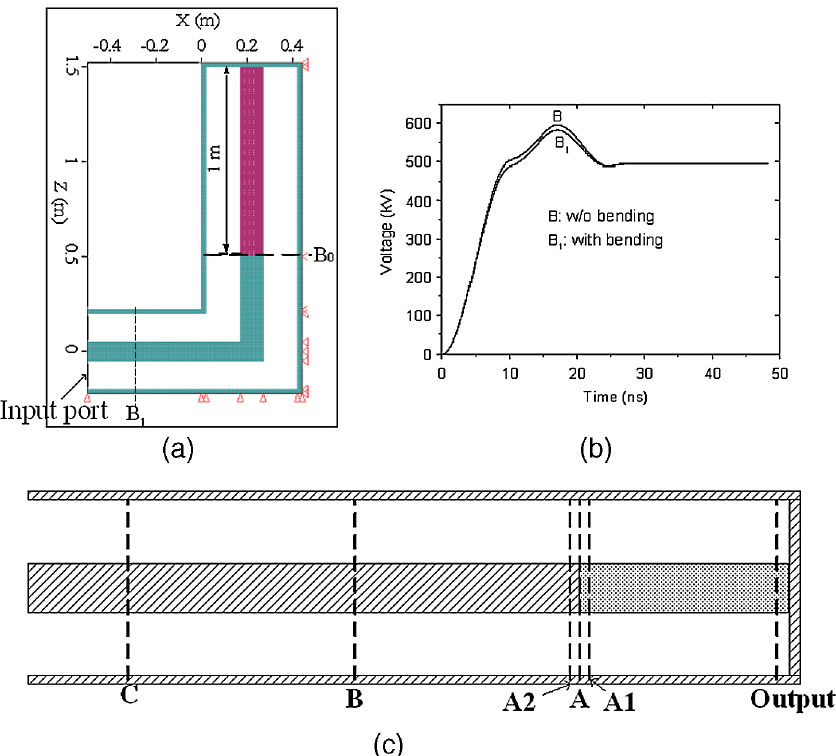
FIG. 3. (Color) Geometry of the water load and simulation result: (a) water load with bending structure; (b) comparison of output voltages for (a) and (c); and (c) water load without bending structure. B0, A: the interface between the inner conductor and the water solution; A1, A2, B, B1: positions of the voltage reading in MAGIC